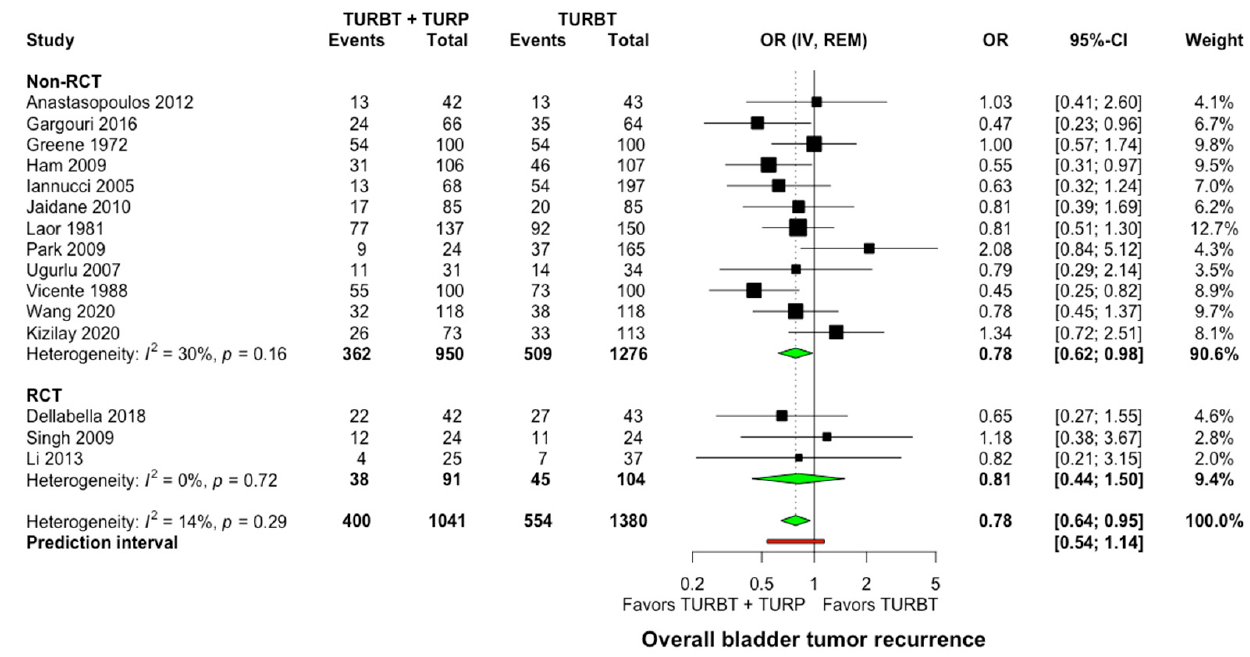
Figure 2. Forest plot comparing concomitant TURBT and TURP versus TURBT in terms of bladder tumor recurrence. CI: confidence interval; IV: inverse variance; OR: odds ratio; RCT: randomized controlled trial; REM: random-effects model; TURBT: transurethral resection of bladder tumor; TURP: transurethral resection of prostate.